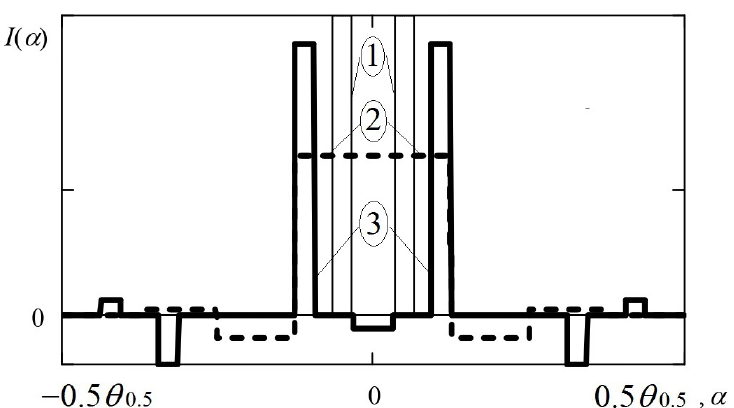
Figure 3. Image reconstruction of point sources at a distance of 0.1 θ 0.5 : 1-signal sources; 2-solution found by the usual algebraic method; 3-solution obtained on the basis of a modification of the algebraic method.